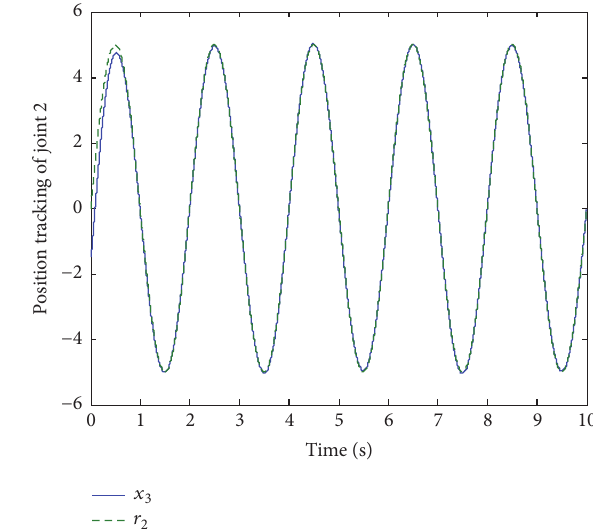
Figure 9: Actual value 𝑥 3 and tracking state of input signal 2.